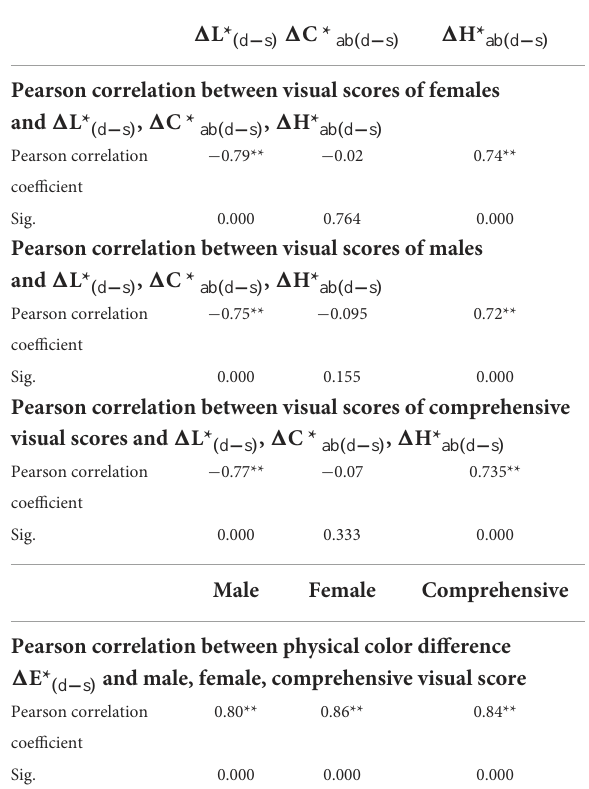
TABLE 7 Pearson correlation